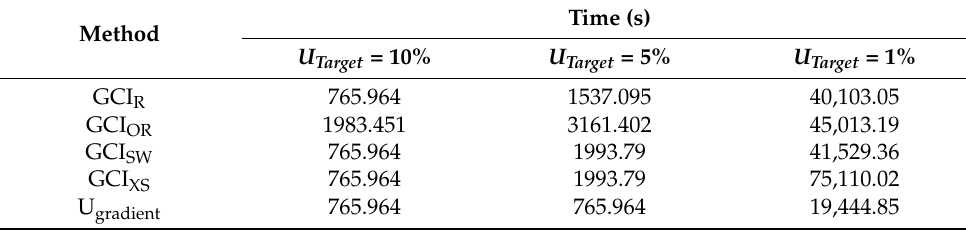
Table 7. The required computational time of the simulation of a flow passes through a